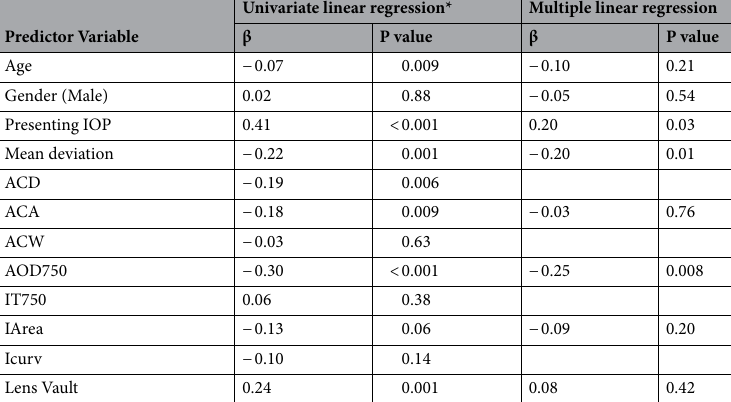
Table 4. Factors associated with peripheral anterior synechiae in eyes with primary angle closure glaucoma. * adjusted for age and gender. IOP intraocular pressure, ACD anterior chamber depth, AOD750 angle opening distance at 750 µm from the scleral spur, TISA750 trabecular–iris space area at 750 µm from the scleral spur, IT750 iris thickness at 750 µm from the scleral spur, IAREA iris area, Icurv iris curvature, ACW anterior chamber width, ACA anterior chamber area, ACV anterior chamber volume, LV lens